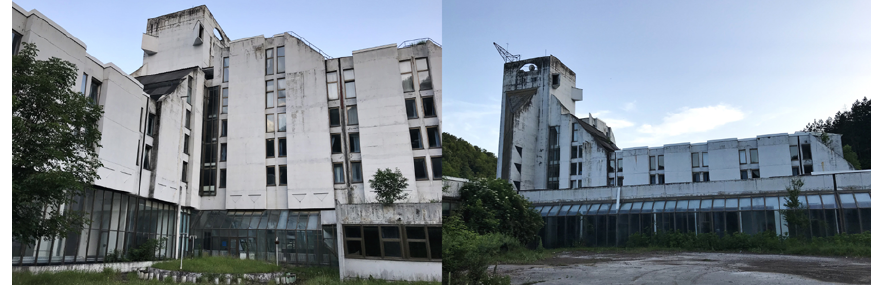
Franc Avbelj et al., Medical and Recreational Center Žubor in Kuršumlija Spa (1976-1982), The Tallest Part of the Center - A1 (Copyright Aleksandra Jevtović, 2019)